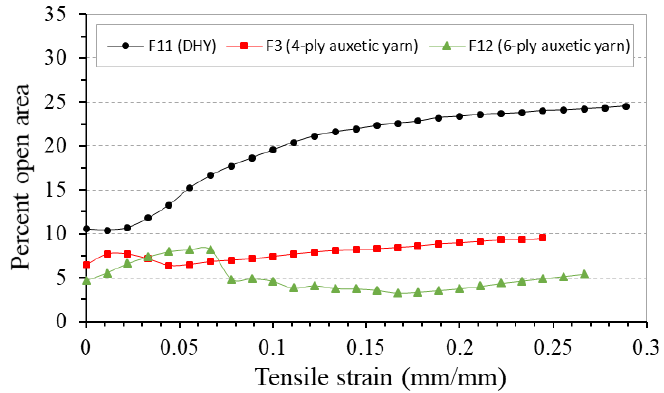
Figure 23. Percent open area-tensile strain curves of fabrics F11, F3 and F12 made of auxetic yarns with different helical structures.